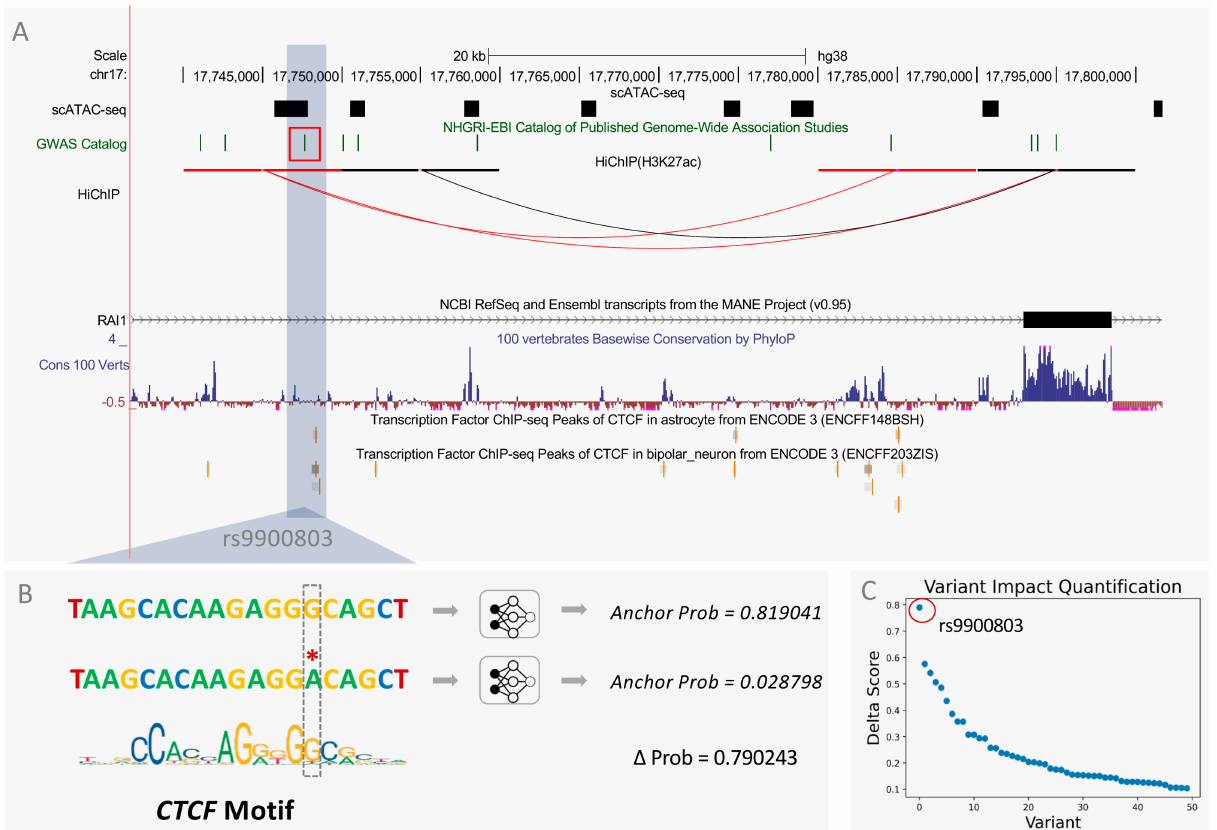
Figure 6. Total nucleotide InsuLock’s variant impact quantification module that predicts the effect of SNVs on the insulator sites. ( A ) Brain scATAC-seq, GWAS, HiChIP, NCBI RefSeq, 100 vertebrates PhyloP conservation, CTCF ChIP-seq peak in astrocytes, and bipolar neuron track on UCSC genome browser. ( B ) Predicted anchor probability of wild-type and mutant sequence. ( C ) Delta scores of GWAS SNPs associated with